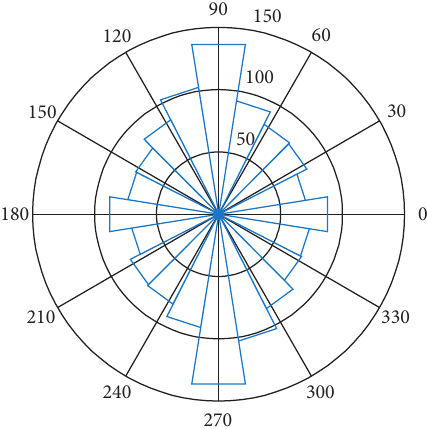
Figure 11: Rose diagram after excavation.